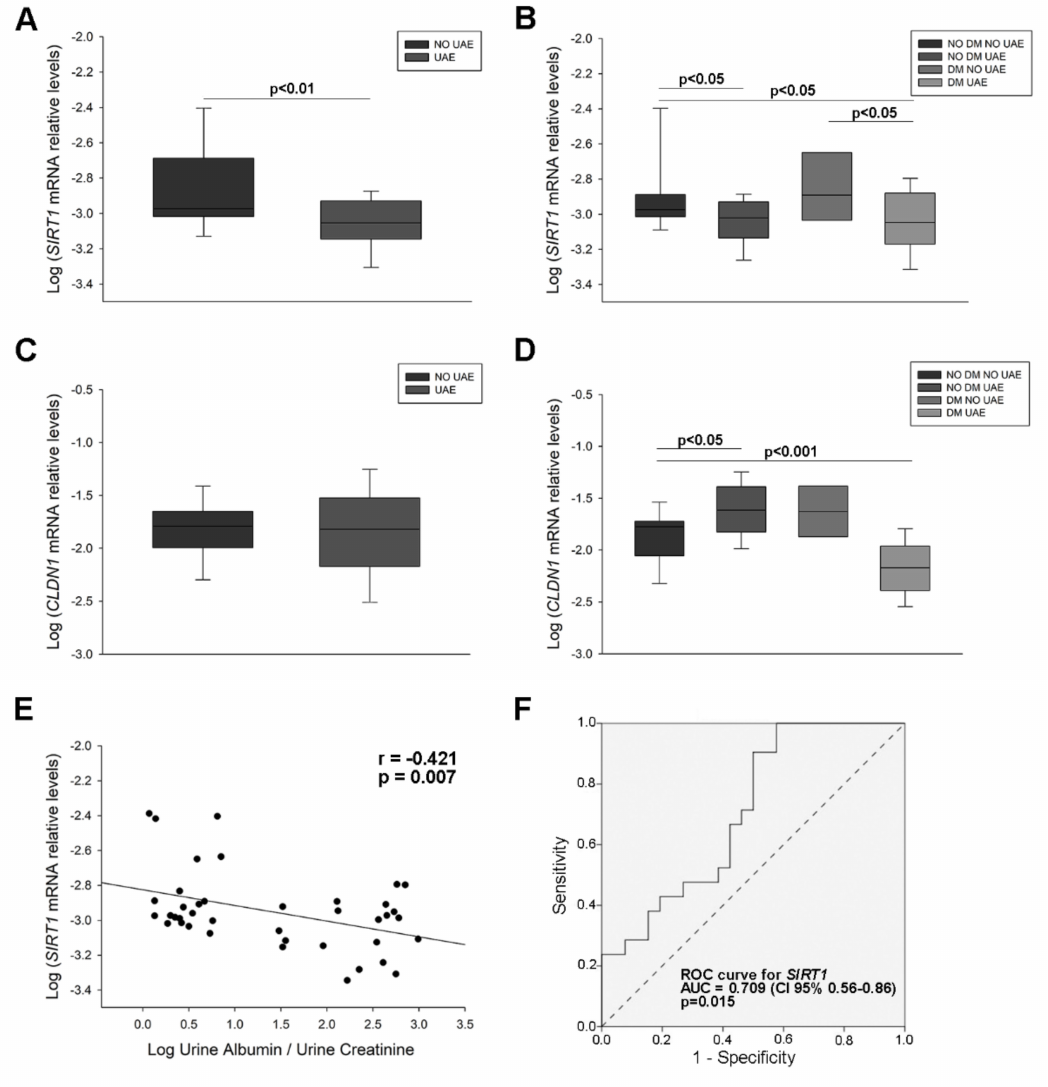
Figure 1. Sirtuin 1 ( SIRT1) and Claudin 1 ( CLDN1) mRNA levels in urinary sediment of hypertensive patients. ( A ) Box plot of the comparison of SIRT1 mRNA levels between patients with increased